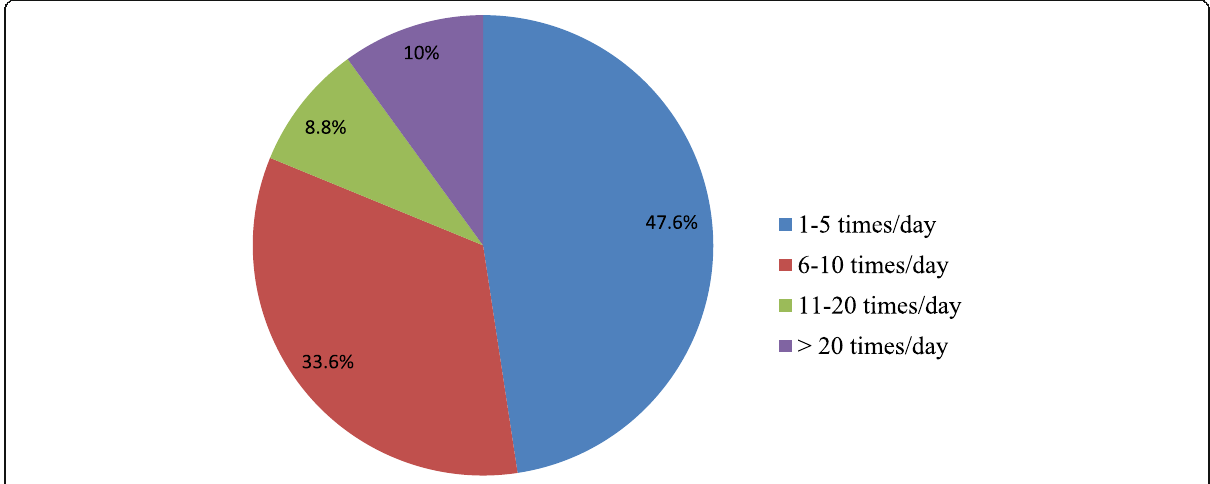
Fig. 1 Hand washing frequencies among healthcare workers in Gondar town, Ethiopia, 2018 ( N = 422)